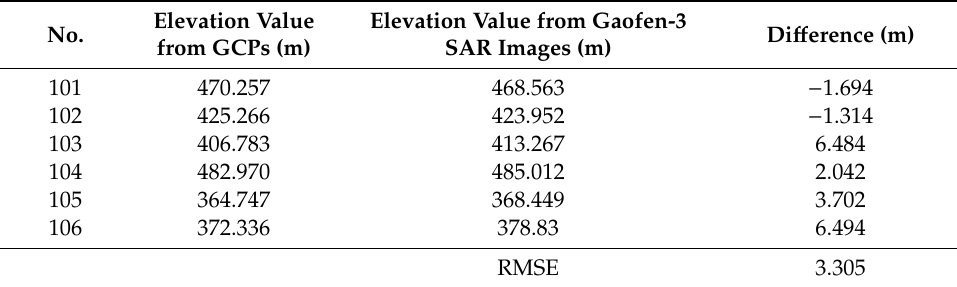
Table 4. Elevation accuracy evaluated by six